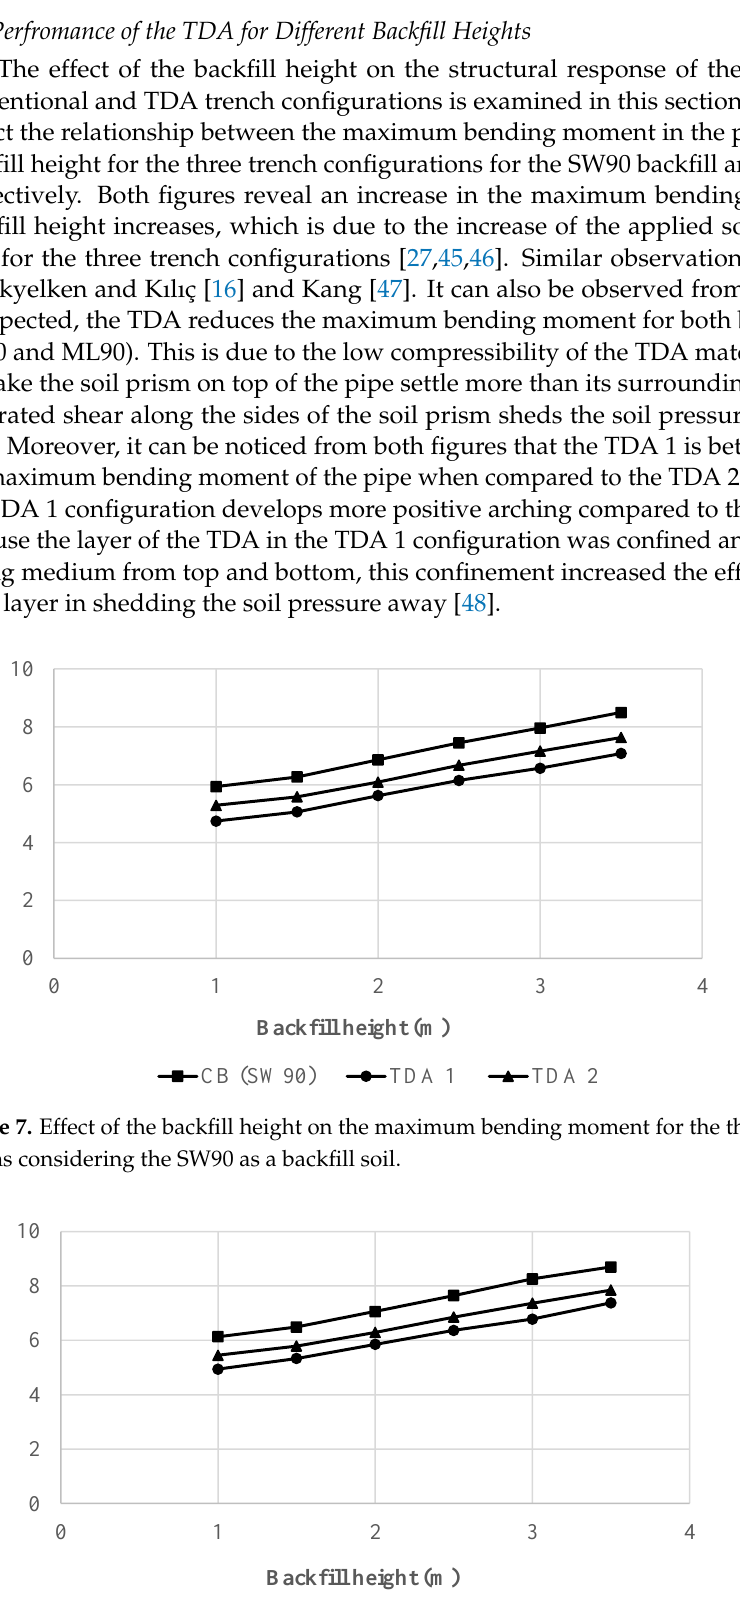
Figure 9. Percentage decrease of the maximum bending moment using TDA 1 and TDA 2 trench configurations for the SW90 backfill.